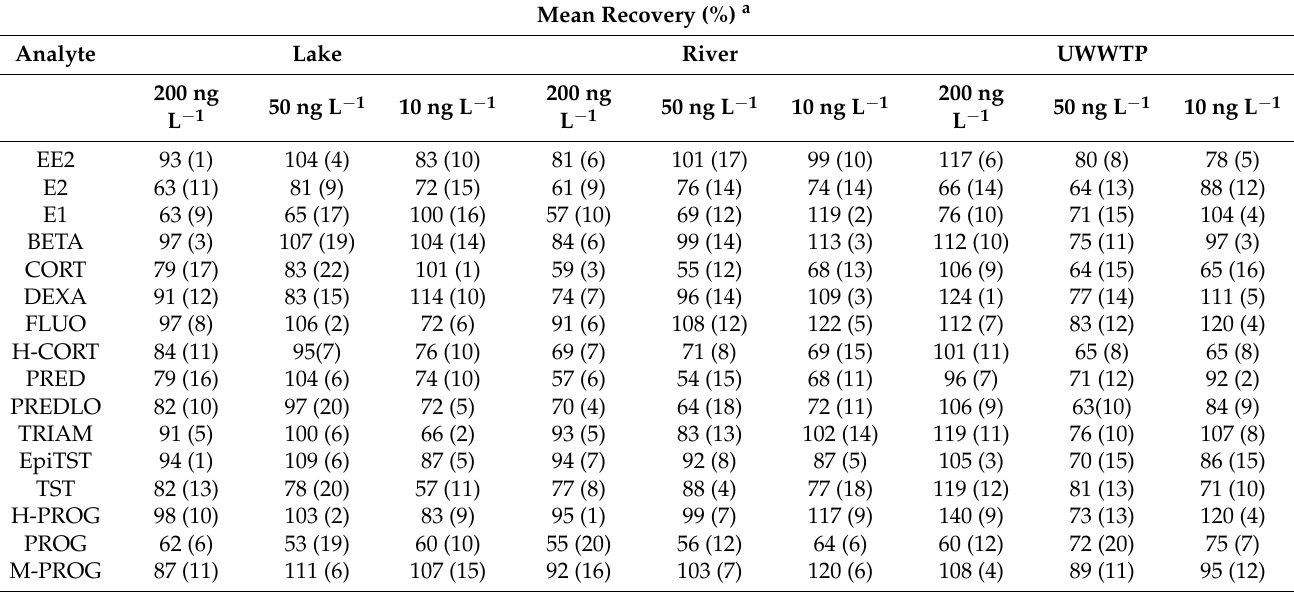
Table 2. Mean recovery values (% R, n = 3) with relative standard deviation (RSD%) observed in lake, river, and UWWTP effluent waters. Mean Recovery (%)